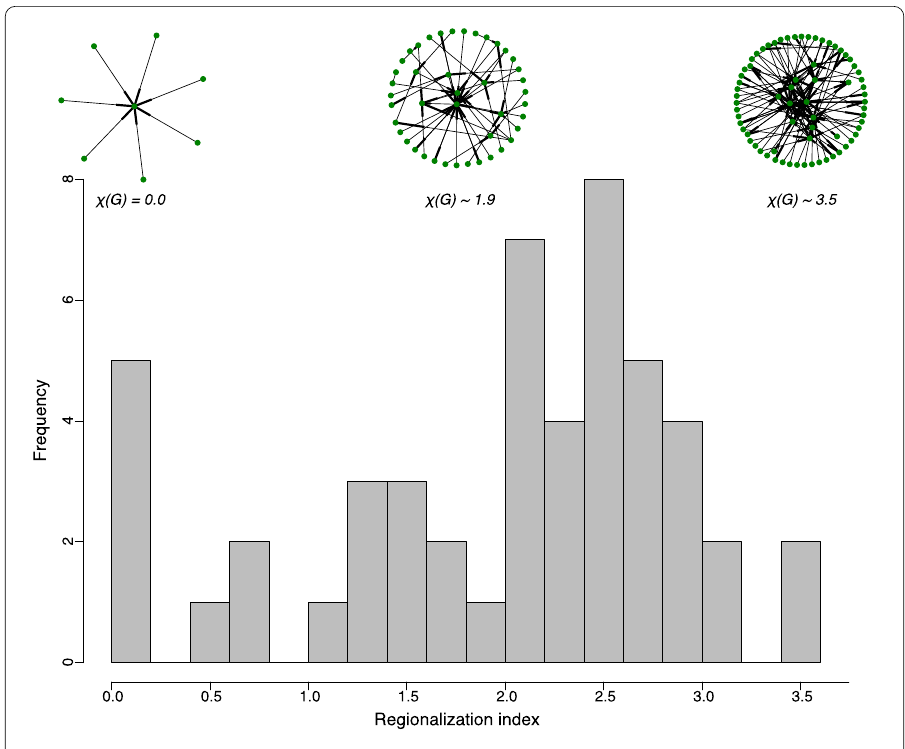
Figure 3 The distribution of regionalization indices across the 50 U.S. VLBW infant transfer network communities. A score of 0 is associated with the most centralized networks, as represented by the empirical network in the top-left of the plot, while a score of 3.5 represents the most regionalized empirical network identified in our study, as represented by the network in the top-right. The mean observed regionalization index observed across the VLBW infant transfer network communities was 1.99, which closely matches the empirical network at h =